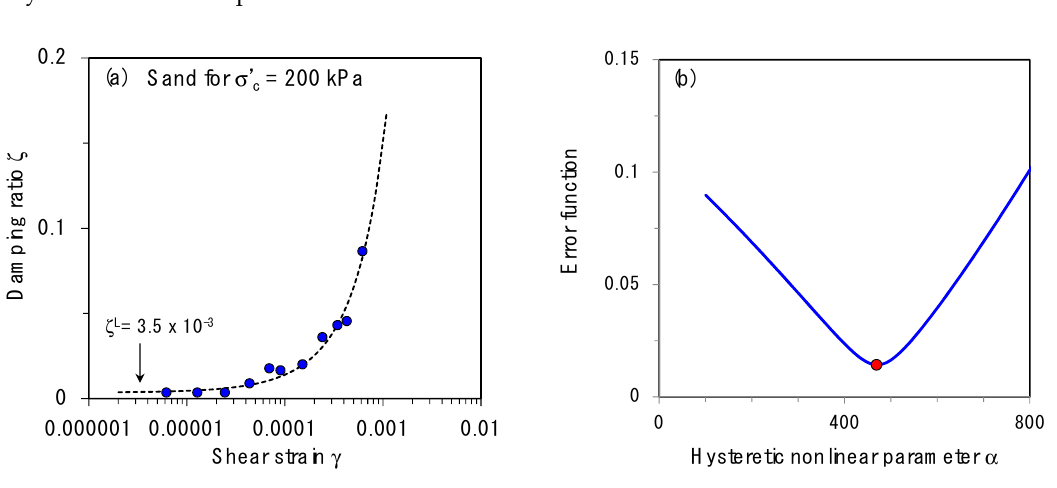
Figure 2. Determination of the hysteretic nonlinearity parameter α using the damping ratio measured from resonant column test (RCT) and the proposed model (sand data from 16 ~ 18 in Table 1): ( a ) Least-squares fitting of the model to measured damping ratio; ( b ) error function (L2 norm)